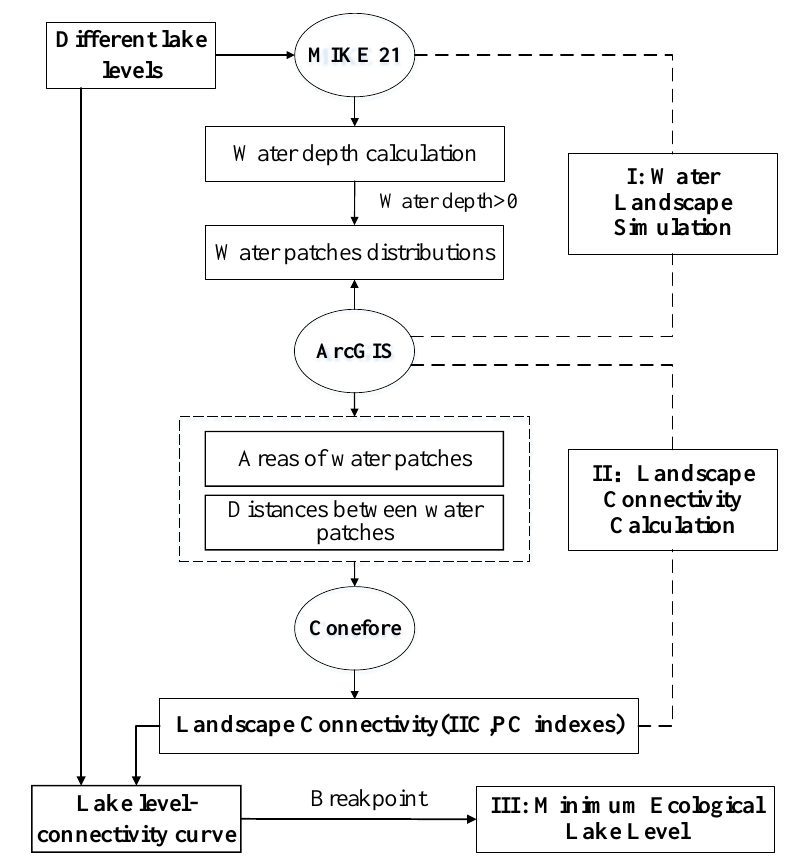
Figure 4. Framework for determining the minimum ecological lake level based on landscape connectivity.